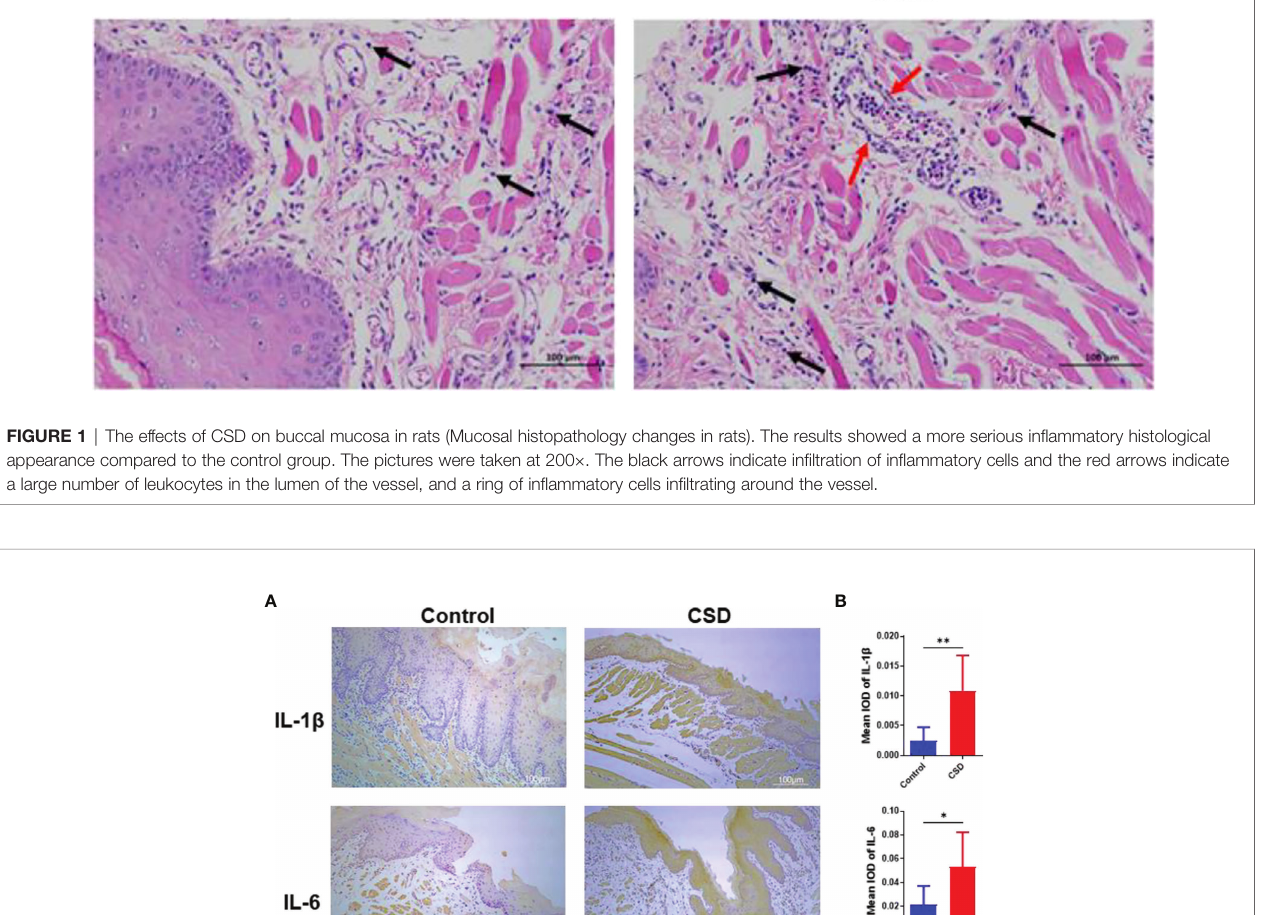
FIGURE 2 | (A) Interleukin (IL)-1 b and IL-6 expressions in epithelial tissue sections of buccal mucosa by immunohistochemistry in the control group and CSD groups. (B) Quanti fi cation of IL-1 b and IL-6 expression in epithelial tissue section of the buccal mucosa. Statistical signi fi cance was analyzed by Student ’ s t test (n = 6, *P < 0.05; **P <